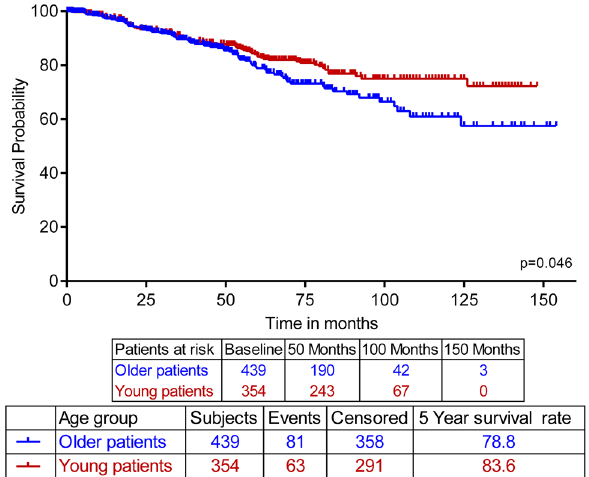
Figure 4. Overall survival of M0 breast cancer patients according to age group. Kaplan–Meier plot shows that the M0 older patients had a significantly worse overall survival rate with a log-rank p = .046.